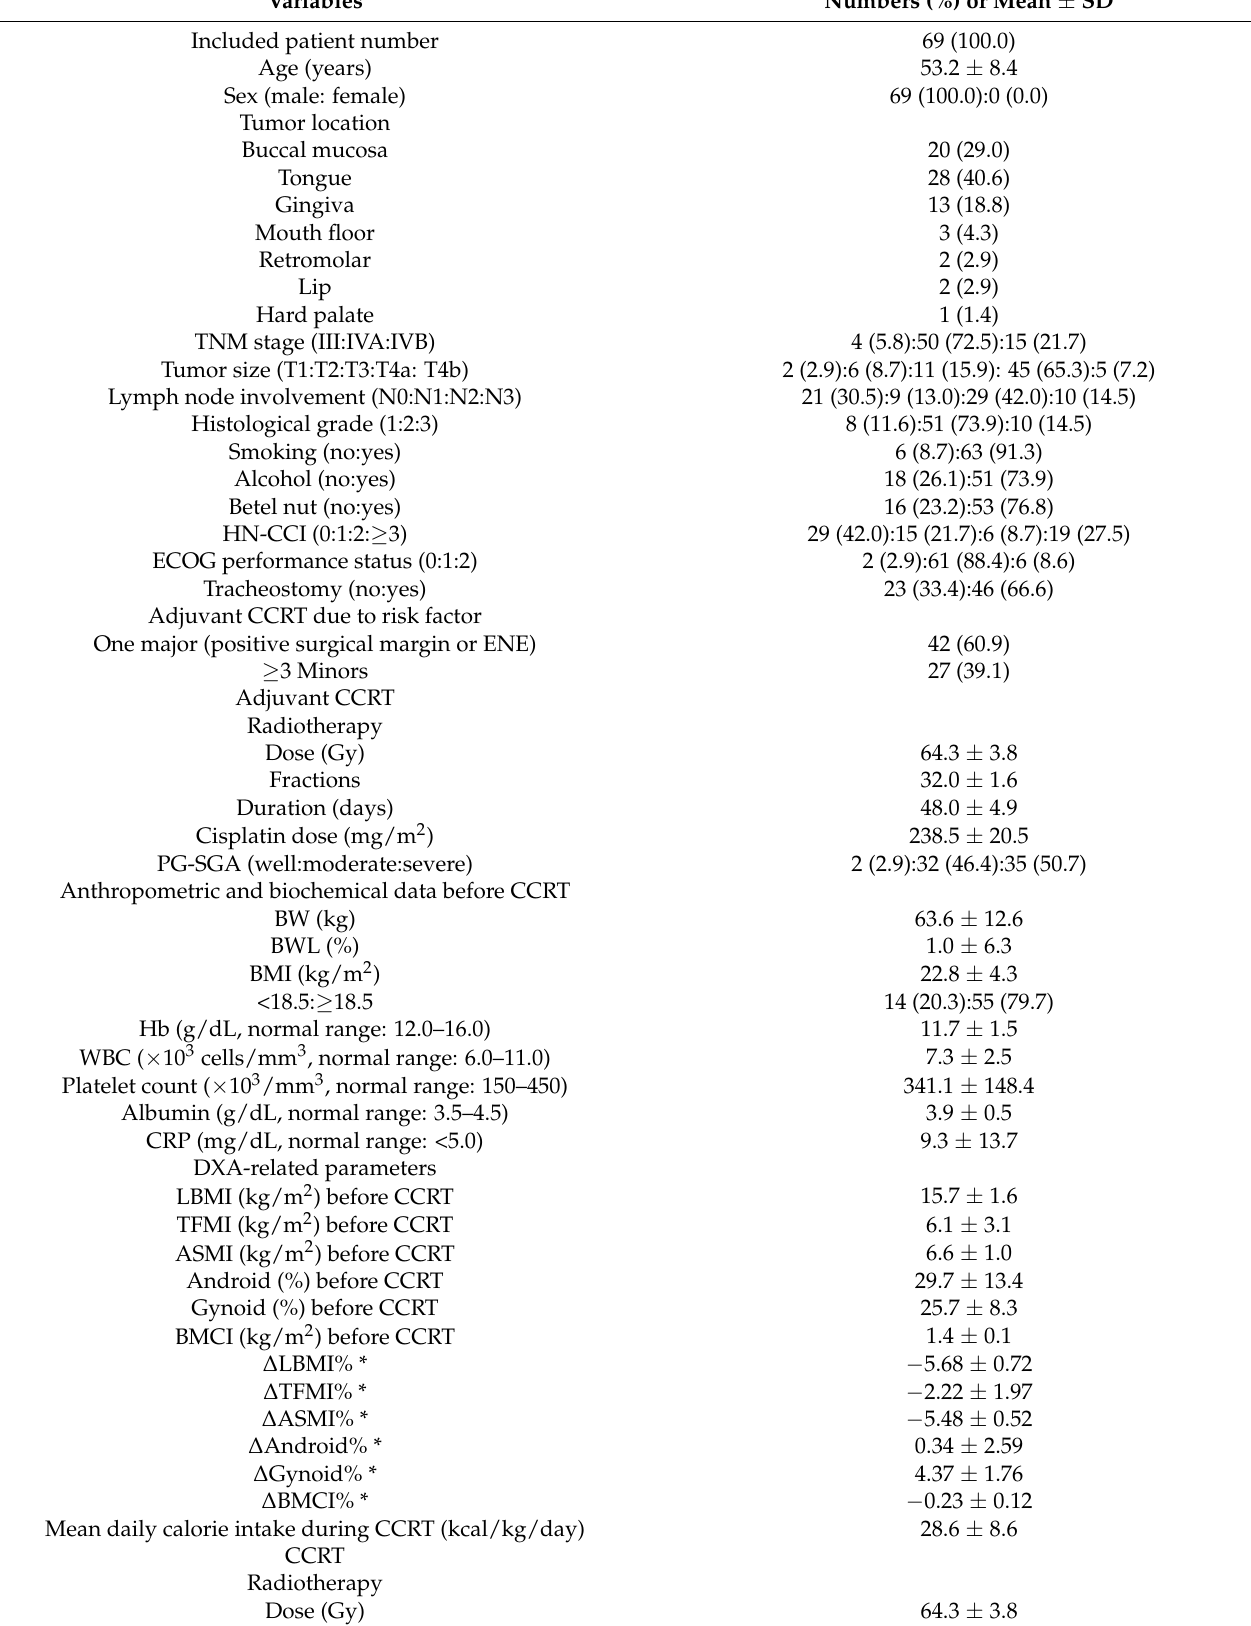
Table 1. Baseline and treatment characteristics of 69 oral cavity cancer patients following postoperative CCRT